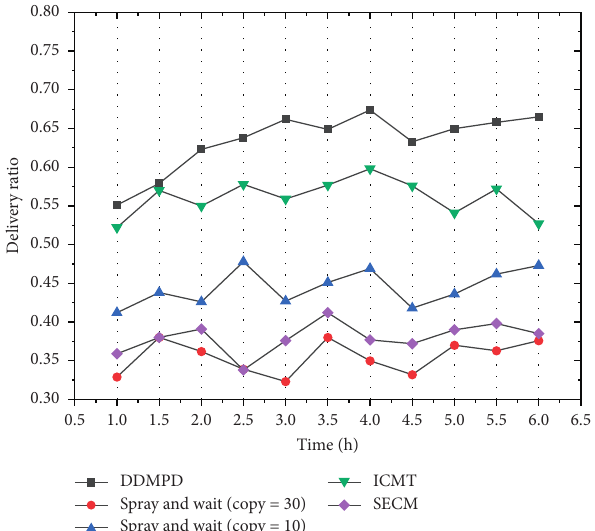
Figure 7: Relationship between delivery ratio and time.